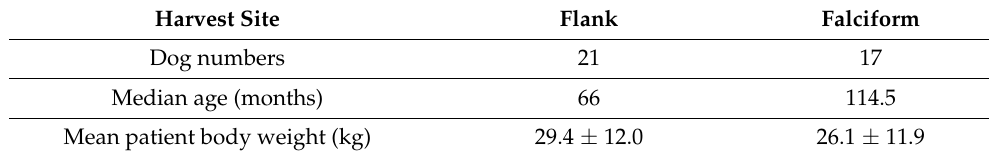
Table 1. Population characteristics such as harvest site, number of dogs, median (range) age, mean ± SD body weight of dogs, and mean ± SD weight of fat from the flank and falciform regions. Harvest